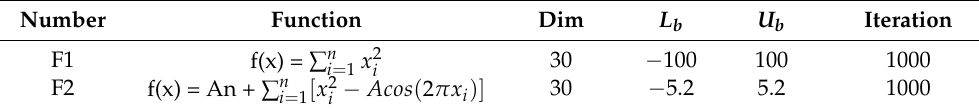
Table 3. Test functions.